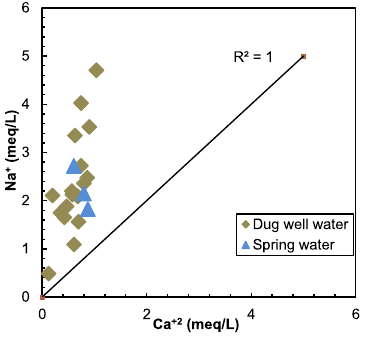
Fig. 6 Na + versus Ca 2+ of the water samples in the study area